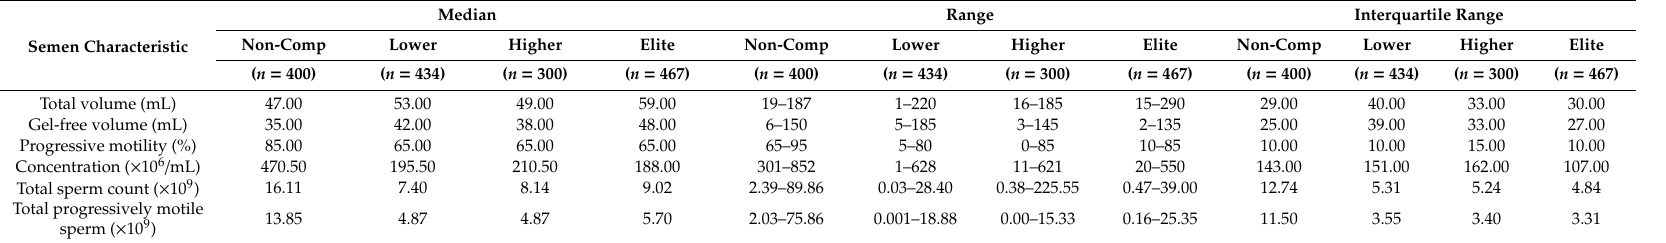
Table 5. Medians, ranges and interquartile ranges for each semen characteristic among stallion competition